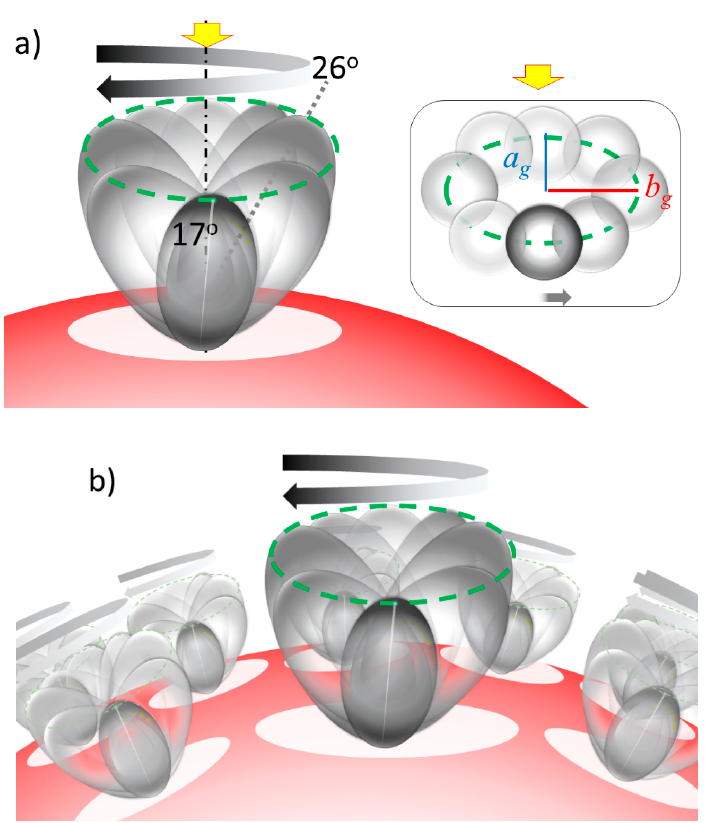
Figure 11. (a ) The sketch showing the gyration motion of a prolate ( a = 2.7 nm and b = 4.0 nm) representing β 2m over a gold nano-particle with a diameter of d = 10 nm, where the prolate major axis tilts between 26° and 17° as it rotates over the surface. It results in an oval occupied space with a g = 2.7 nm and b g = 4.0 nm. (See Table 3) ( b ) The sketch of a gyrating prolate over the nano-gold particle surface.